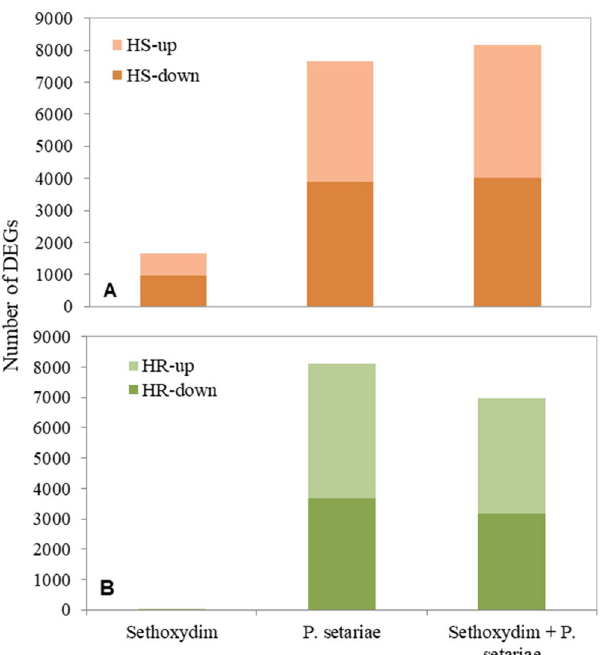
Figure 4. Number of up- and down-regulated differentially expressed genes (DEGs) obtained for HS- ( A ) and HR-GFT ( B ) under the sethoxydim, P. setariae and sethoxydim + P. setariae treatments. DEGs were based on the comparison against the reference GFT genomes constructed by de novo